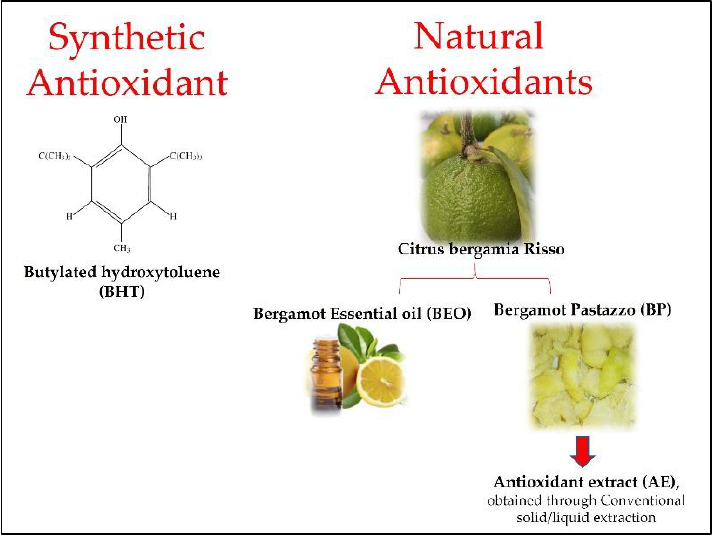
Figure 1. Synthetic and natural antioxidants used to enrich the edible coatings. The butylhydroxytoluene (BHT) was purchased from Merck KGaA (Darmstadt,